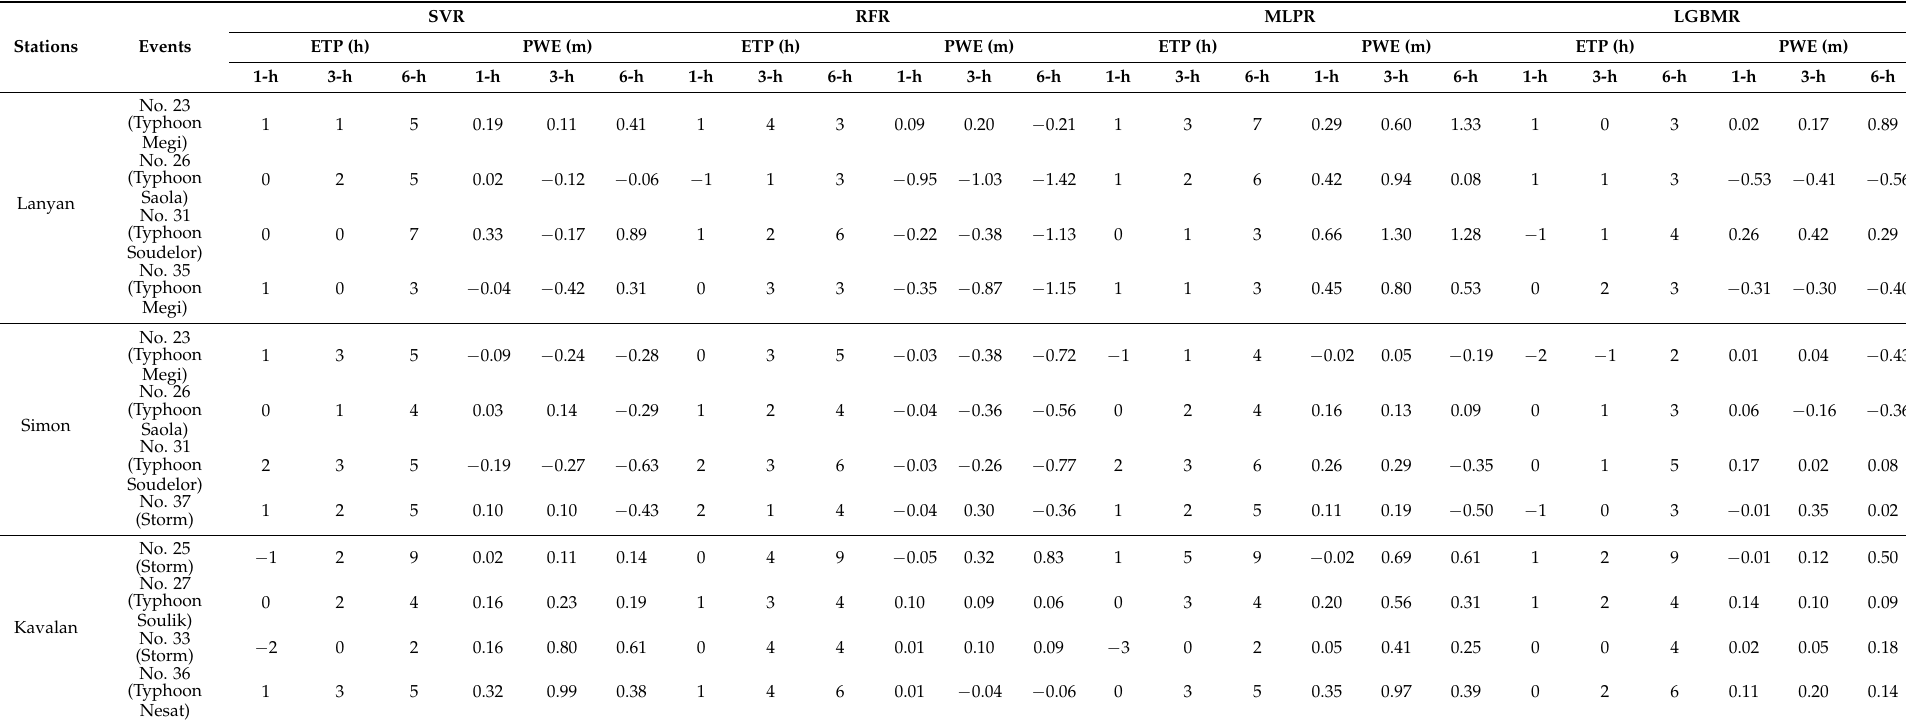
Table 8. The model validation results displaying lead times of 1, 3, and 6 h at three